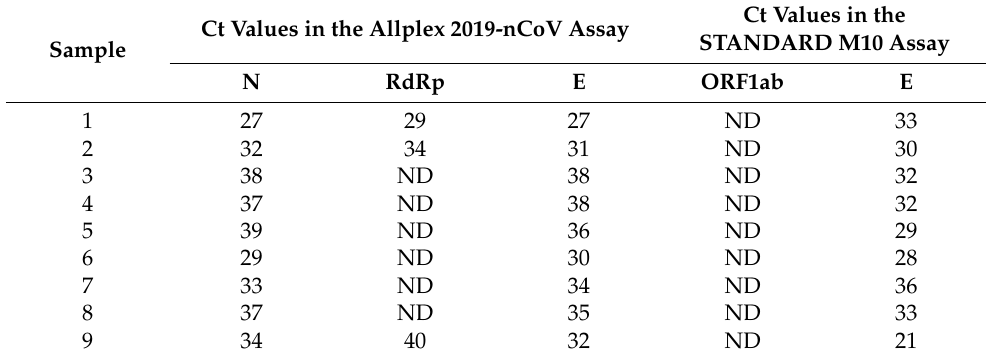
Table 2. Characteristics of samples with “Presumptive positive” result label in the STANDARD M10 assay ( n =